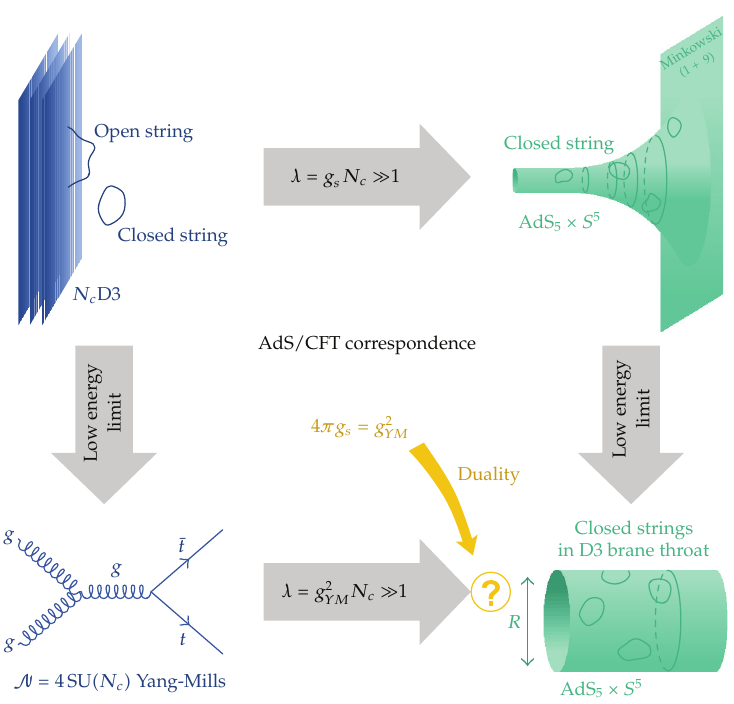
Figure 3: The sketch of the AdS/CFT